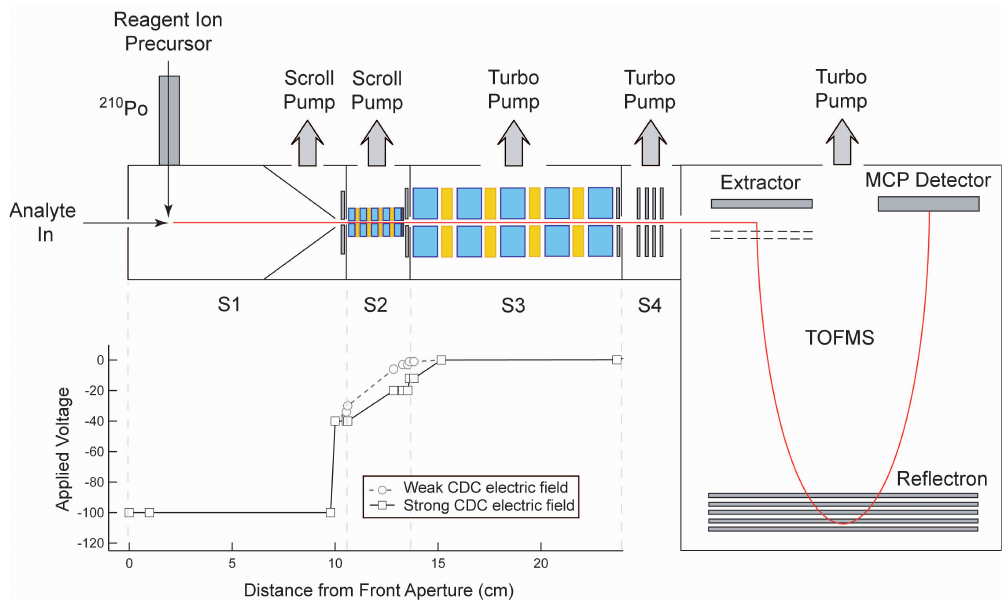
Fig. 1. Schematic of the chemical ionization source and four stage (S1–S4) differentially pumped interface coupled to the time-of-flight mass spectrometer (TOFMS, 5 × 10 − 7 mbar). The high pressure interface consists of: (i) ion-molecule reaction (IMR) chamber (S1, 85mbar), (ii) collisional dissociation chamber (CDC) (S2, 2mbar), (iii) stage 3 that houses a second RF-only segmented quadrupole (S3, 1.5 × 10 − 2 mbar), and (iv) stage 4 that houses a series of DC optics that focus and accelerate the primary beam into the TOFMS (S4, 3.5 × 10 − 5 mbar). DC voltages applied to the focusing electrodes under two different declustering conditions, are shown in the inset figure, as a function of the distance from the entrance